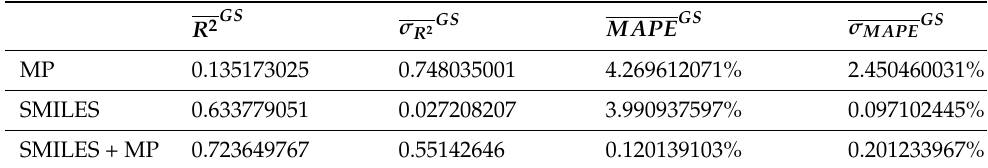
Table 4. The average results for N = 672 tested architectures in GS. (MP—molecular properties, R 2 —coefficient of determination, MAPE —mean absolute percentage error, GS—grid